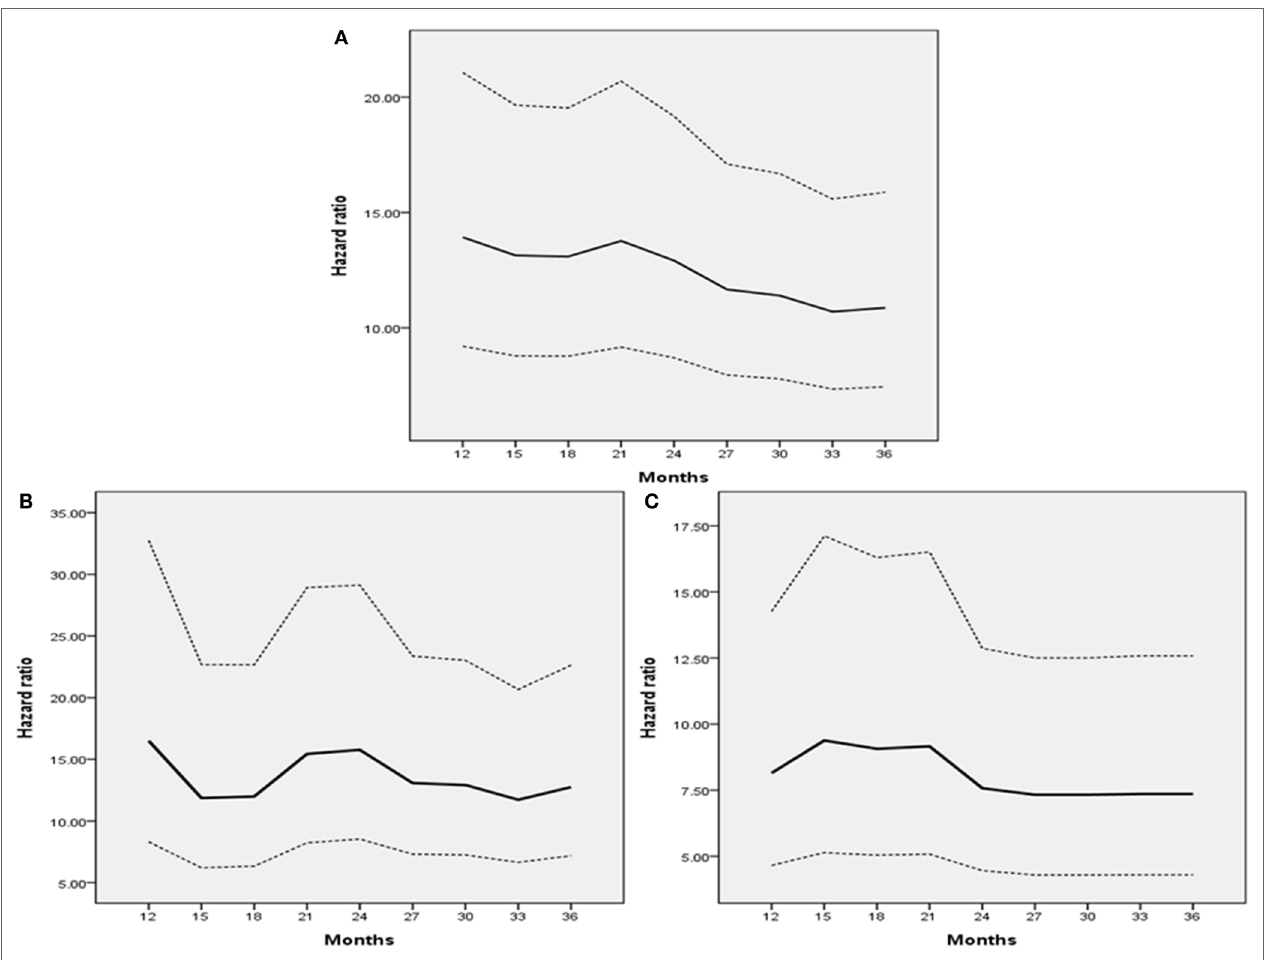
FigUre 3 | hazard ratio of landmark analysis at each time point . (a) All patients. (B) Patients with pT2 or less disease. (c) Patients with pT3 or greater disease. Dashes indicate 95% confidence